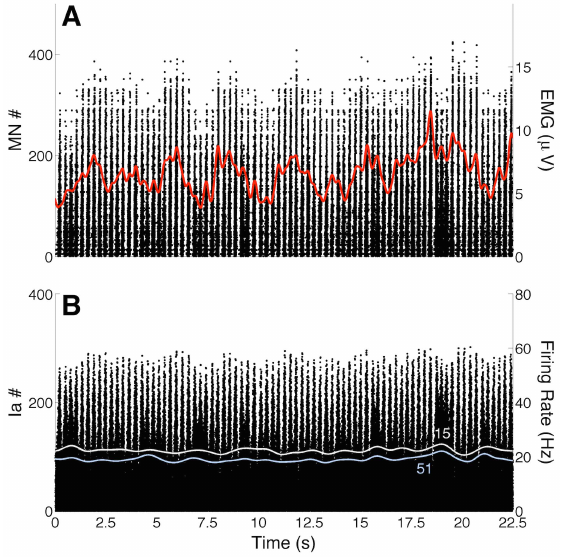
Figure 5. Typical behaviour of Soleus (SO) motor units (MUs) and Ia afferents. (A) Raster plots (black dots) and SO electromyogram (EMG) envelope (red curve). Note that the SO muscle has an approximately steady activation during postural sway (not too much recruitment and de-recruitment). (B) Raster plots from SO muscle spindle Ia afferents and instantaneous firing rate for two selected afferents (continuous curves for afferents 15 and 51). Note the small modulation in Ia afferent recruitment and firing